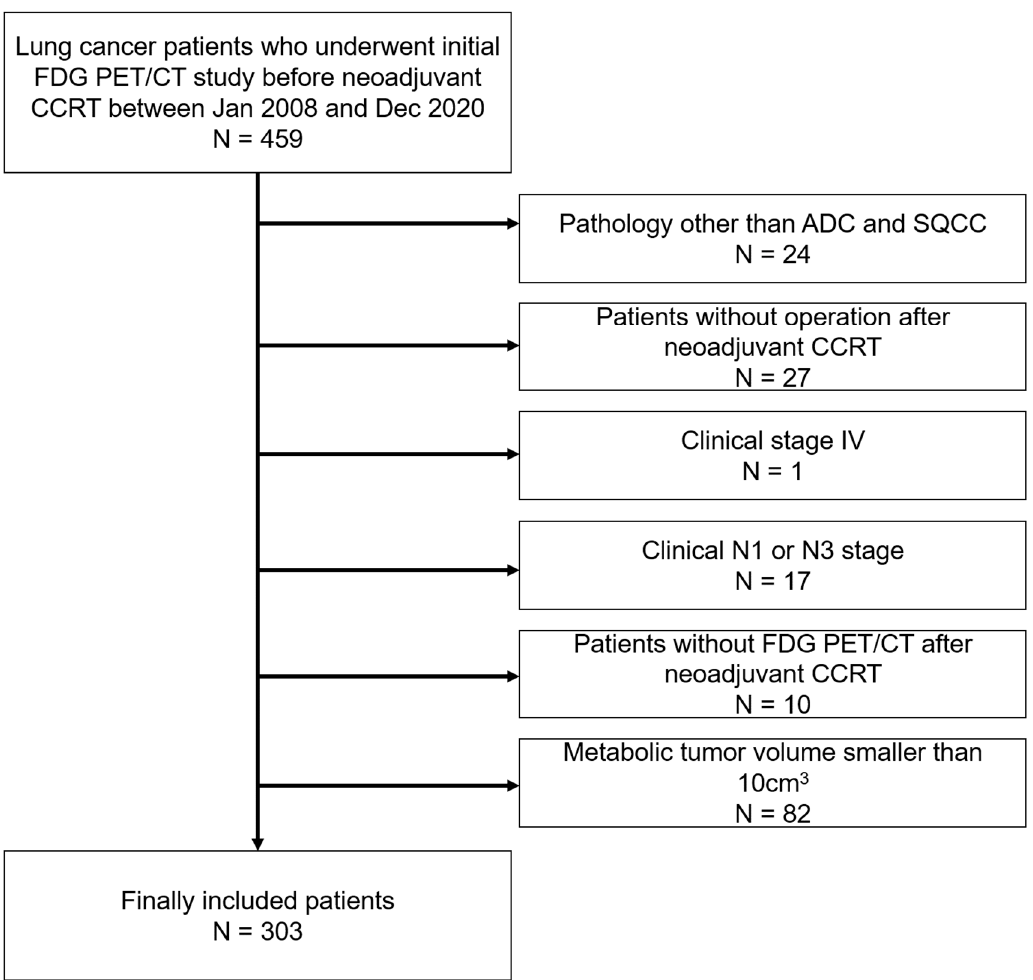
Figure 1. Patient inclusion and exclusion criteria. Four hundred fifty-nine patients were retrospec- tively enrolled. Among them, patients with pathologies other than adenocarcinoma or squamous cell carcinoma, those who did not undergo curative surgery after neoadjuvant concurrent chemora- diation therapy (CCRT), those with clinical stage IV or clinical stage N1 or N3 disease, those without follow-up FDG PET/CT after neoadjuvant CCRT, and those with tumor volumes smaller than 10 cm 3 were subsequently excluded. Ultimately, 303 patients were